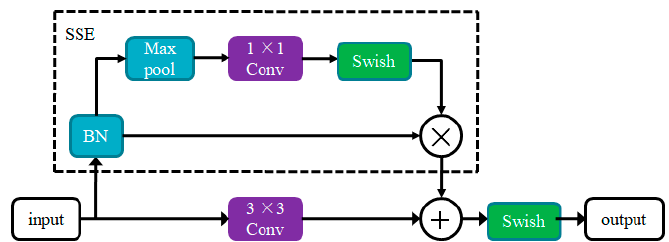
Figure 1. The RepVGG Skip Squeeze Excitation (RSSE)